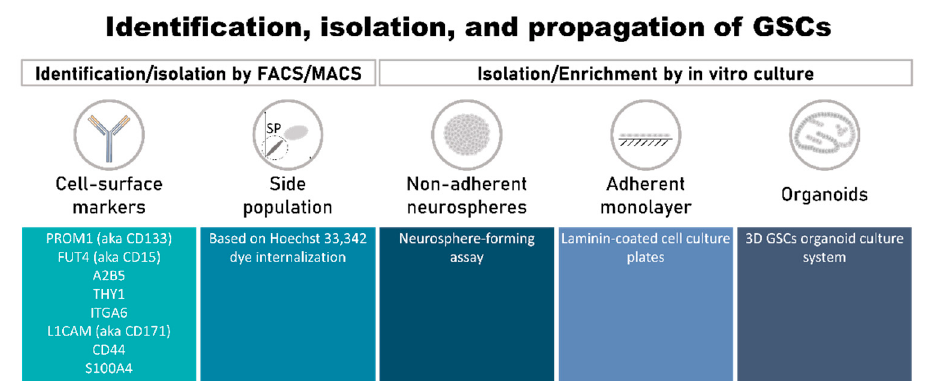
Figure 1. Methods used for glioma stem cell (GSC) identification, isolation, and propagation. GSCs can be identified and isolated either by fluorescence-activated cell sorting (FACS) or magnetic-activated cell sorting (MACS) based on their expression of cell-surface markers (e.g., CD133, CD15, CD90, and A2B5), or based on the differential efflux of Hoechst 33,342 dye by a multidrug-like transporter using the side-population (SP) assay. Additionally, GSCs can be enriched in vitro using three techniques: the neurosphere-forming assay, the culture of adherent monolayers in laminin-coated plates, or using 3D organoid culture systems.